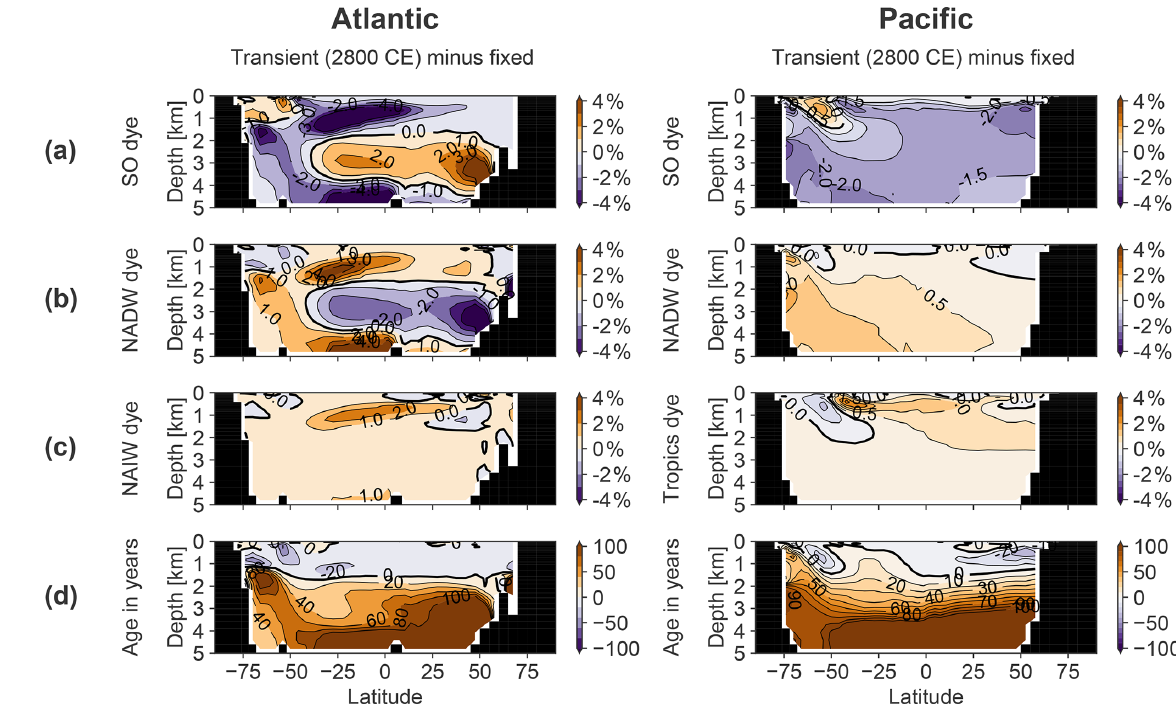
Figure A3. Zonally average meridional sections of the Atlantic and Pacific basins, including their Southern Ocean sector. Shown are the anomalies of transient (OcTRA) with respect to fixed (OcFIX) dye tracer for the year 2800CE (the end of the simulation) of (a) Southern Ocean dye tracer, (b) North Atlantic Deep Water dye tracer, (c) North Atlantic Intermediate Water dye tracer (for Atlantic) and tropics dye tracer (for Pacific), and (d) ideal age. Units for dye are a fraction of initial dye concentration at the surface, in